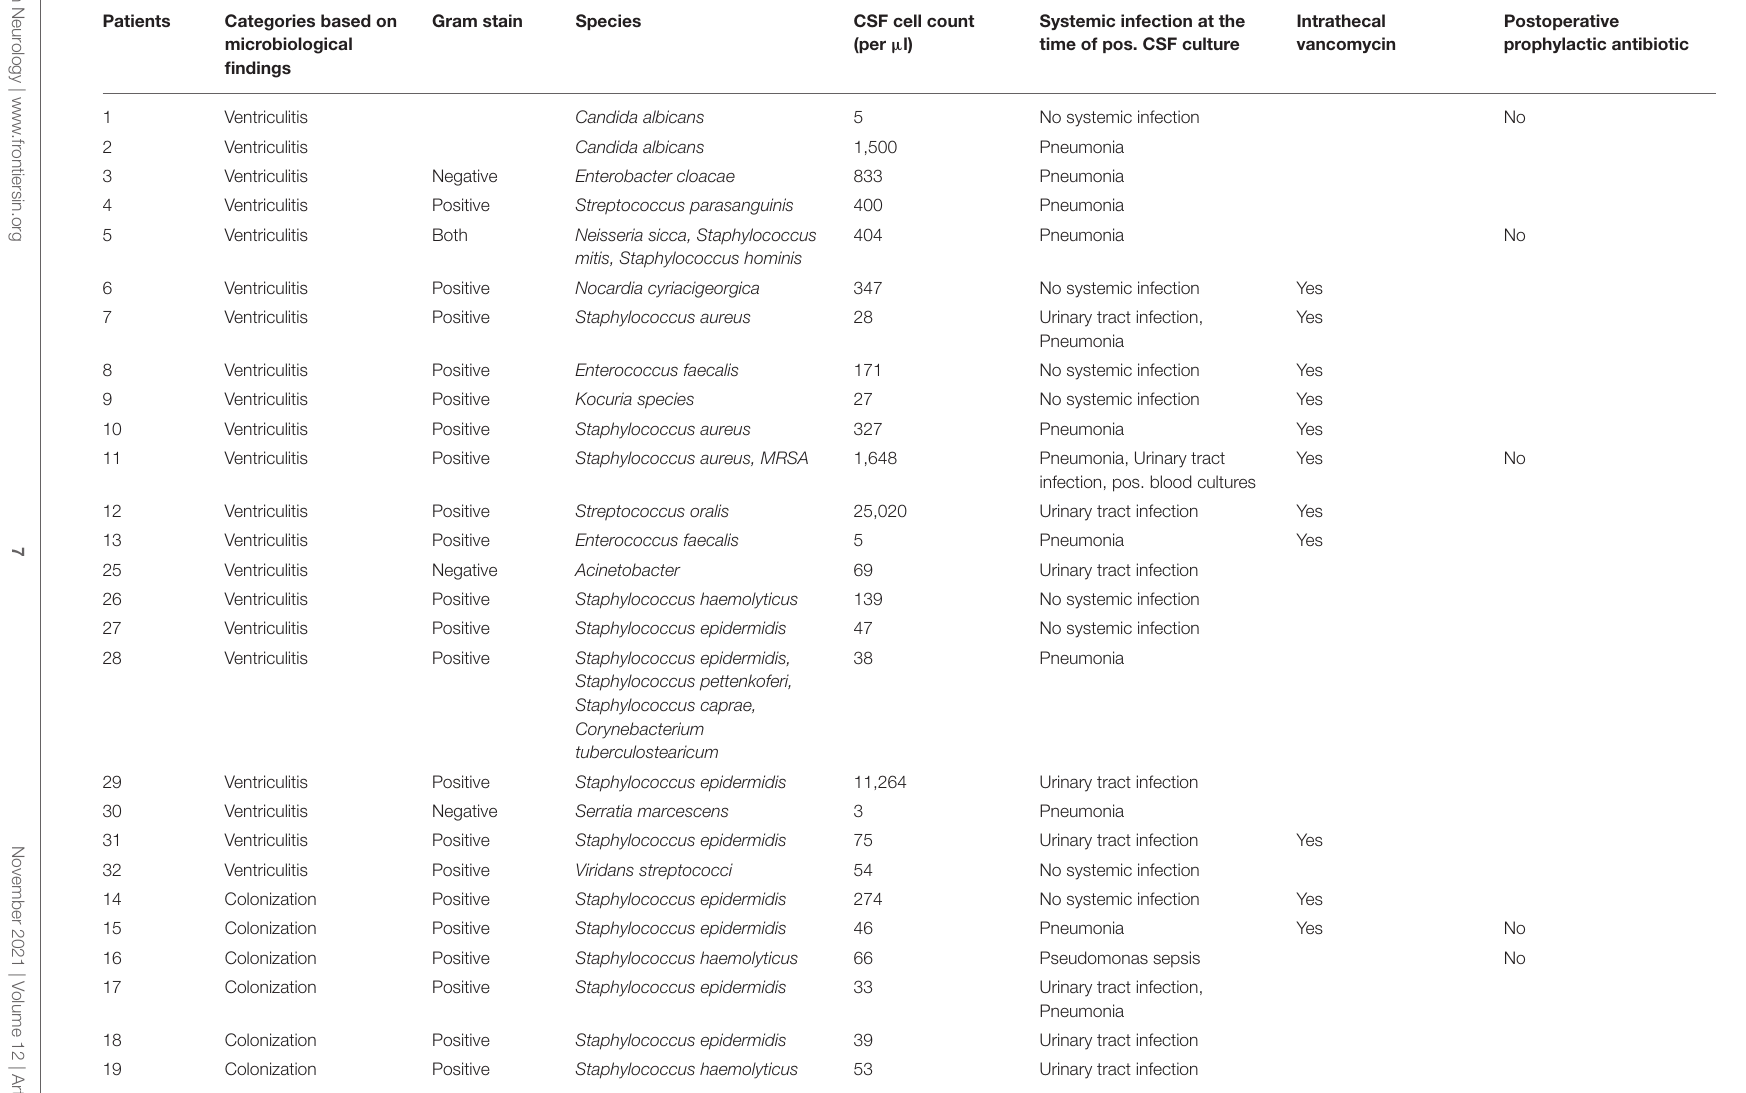
TABLE 5 | Characteristics of patients with EVD associated